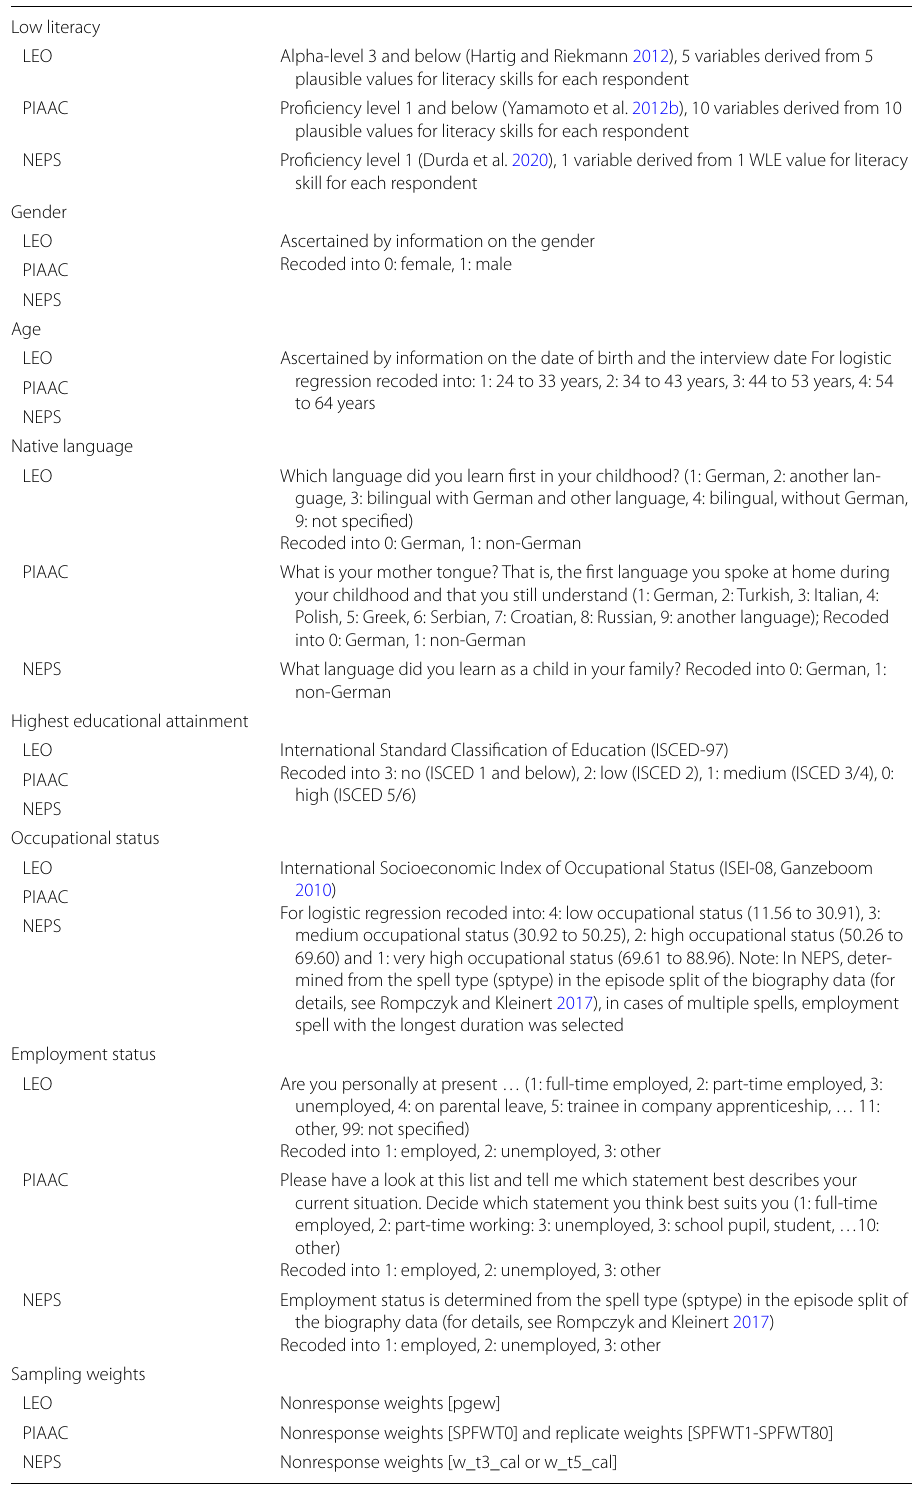
Table 4 Overview of variables and how they are measured Variable Survey instrument Low